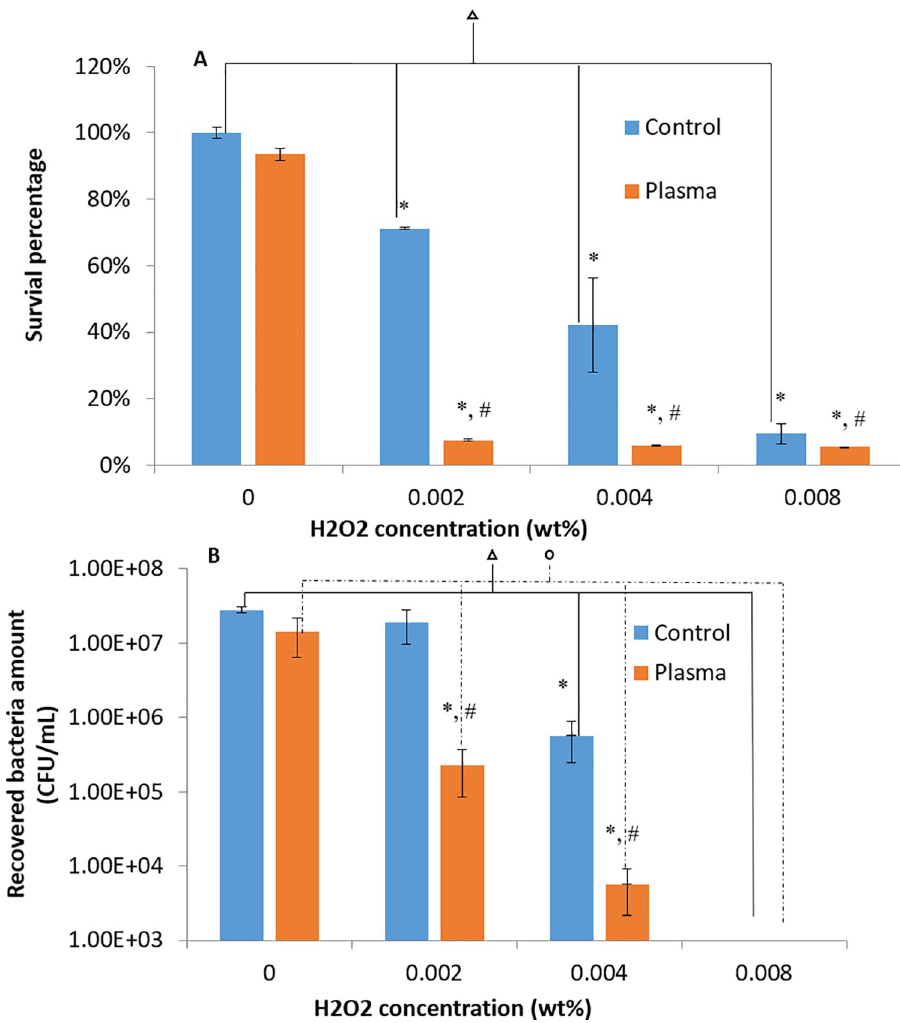
Fig 9. Biofilm recovery results under oxidative stress of H 2 O 2 from (A) MTT assay and (B) CFU counting assay for untreated and 1-min argon+1% oxygen plasma treated 3-day P . gingivalis biofilms. � denote the statistically significant difference (p < 0.05) compared with the control groups without H 2 O 2 treatment. # denotes the statisticall significant difference (p < 0.05) between untreated controls and plasma treated groups. denotes the statistically significant differences among different H 2 O 2 doses for non-plasma treated biofilms with p < 0.05 according to ANOVA Tukey test. denotes the statistically significant differences among different H 2 O 2 doses for plasma treated biofilms with p < 0.05 according to ANOVA Tukey